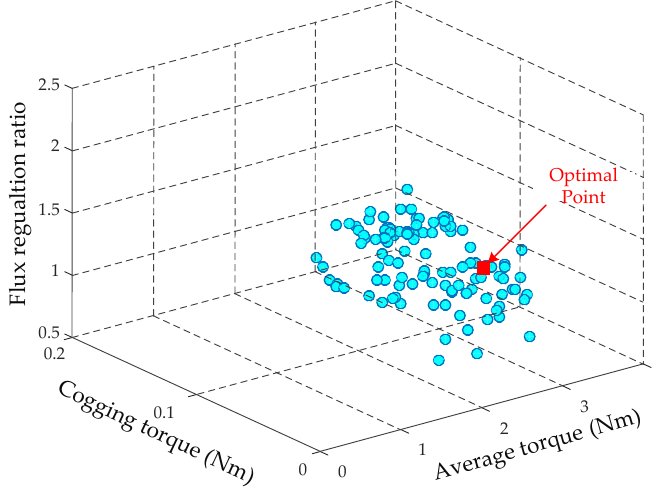
Figure 10. Comprehensive optimization using MOGA method. Table 3. Optimal values of design variables